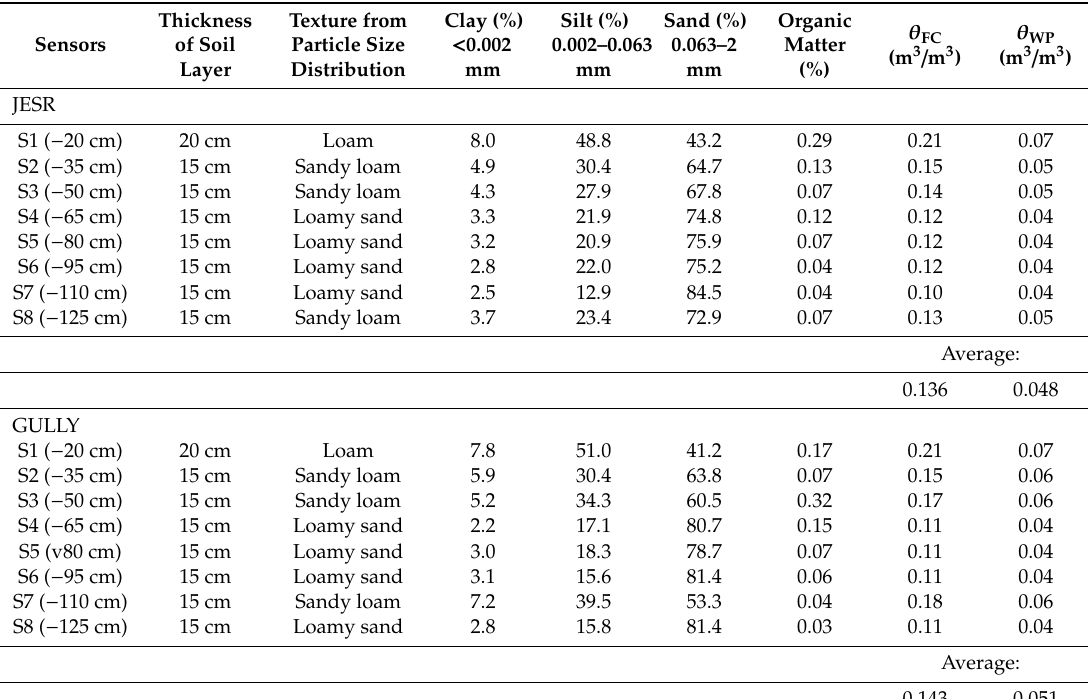
Table 3. Soil sample analysis for each layer in the Jesr and gully profiles: texture class, organic matter content and soil moisture content at field capacity ( θ FC ) and at wilting point ( θ WP ).